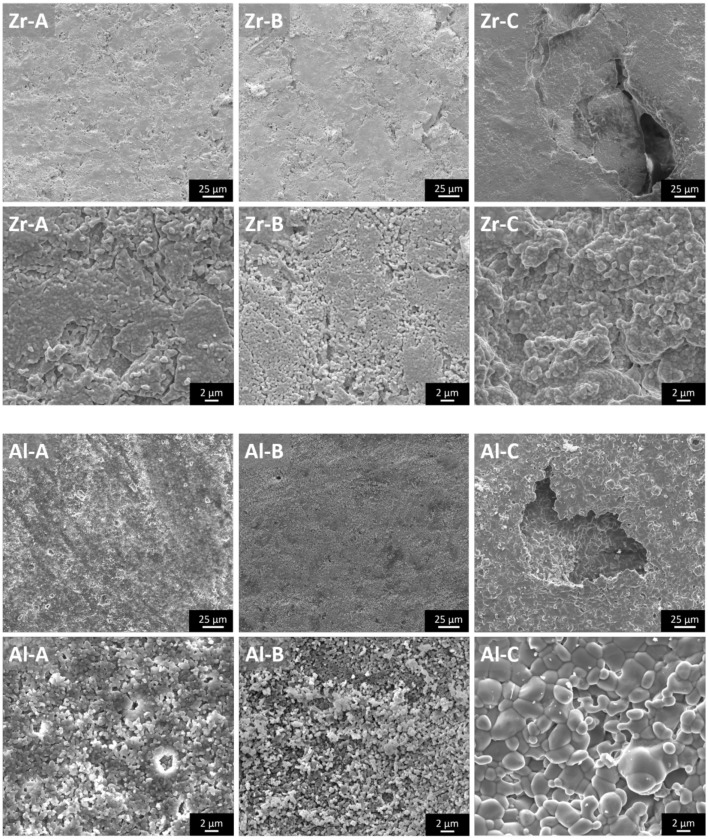
The microstructure of zirconia and alumina ceramics as shown by scanning electron microscopy images. The large pores of nanostructural Zr-C and microstructural Al-C ceramics are visible. Original magnifications are ×1000 for larger and ×8000 for smaller scale bar images.